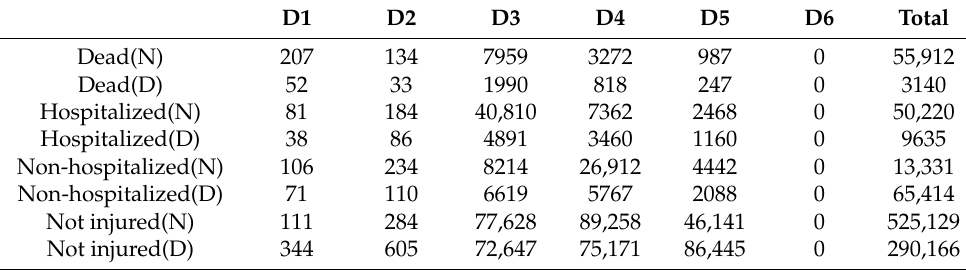
Table 22. Number of casualties in the 1780 earthquake in District 3 of Tabriz.